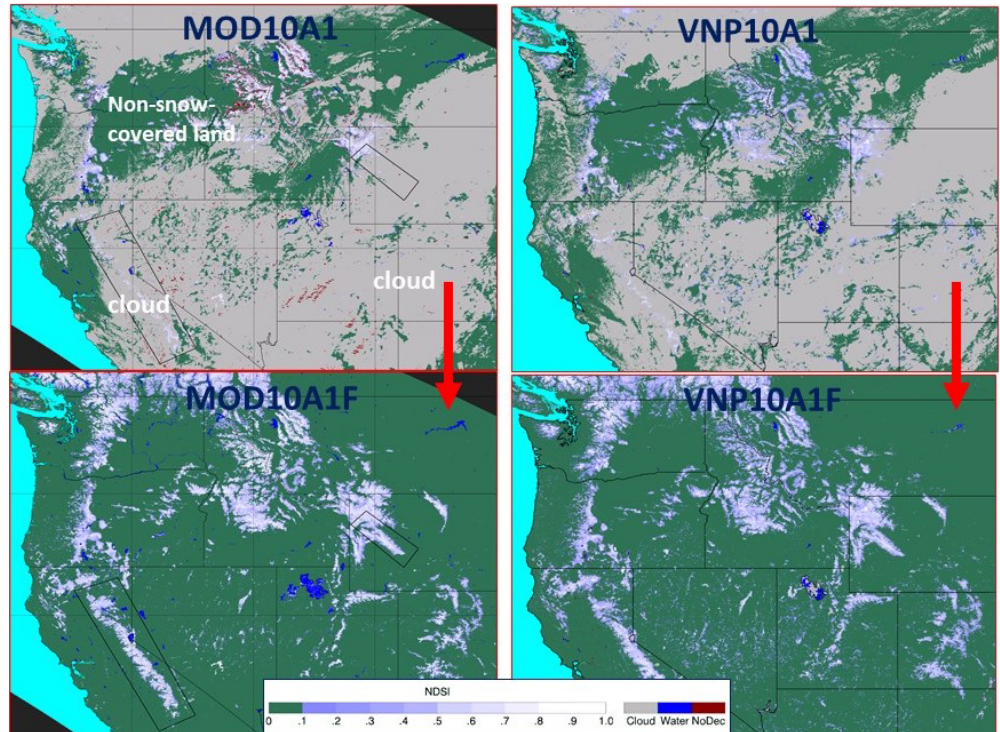
Figure 2. Examples of MODIS and VIIRS standard and cloud-gap-filled (CGF) snow maps on 14 April 2012 for a study area in the western US/southwestern Canada (see Fig. 1). Top left panel: MODIS MOD10A1 C6.1 snow map showing extensive cloud cover on 14 April 2012. Top right panel: VIIRS VNP10A1 C1 snow map also showing extensive cloud cover on 14 April 2012. Bottom left panel: MOD10A1F C6.1 CGF map corresponding to the MOD10A1 snow map in the top left panel, also for 14 April 2012. Bottom right panel: VNP10A1F CGF map corresponding to the VNP10A1 snow map in the top right panel, also for 14 April 2012. In all of the snow maps, non-snow-covered land is shown in green. Regions of interest containing the Sierra Nevada Mountains in California and Nevada (109575km 2 ), and the Wind River Range in Wyoming (22171km 2 ), are outlined using dark blue on the MODIS snow maps. The following MODIS tiles were used to develop the MODIS composites: h08v04, h09v04, h10v04, h08v05, h09v05, and h10v05. Each VIIRS swath that included coverage of this study area was composited to create a daily map; the daily maps were then used to create the VNP10A1F snow map for 14 April 2012. The base map was obtained from Interactive Data Language (IDL) software that uses Natural Earth raster + vector map data, which are in the public